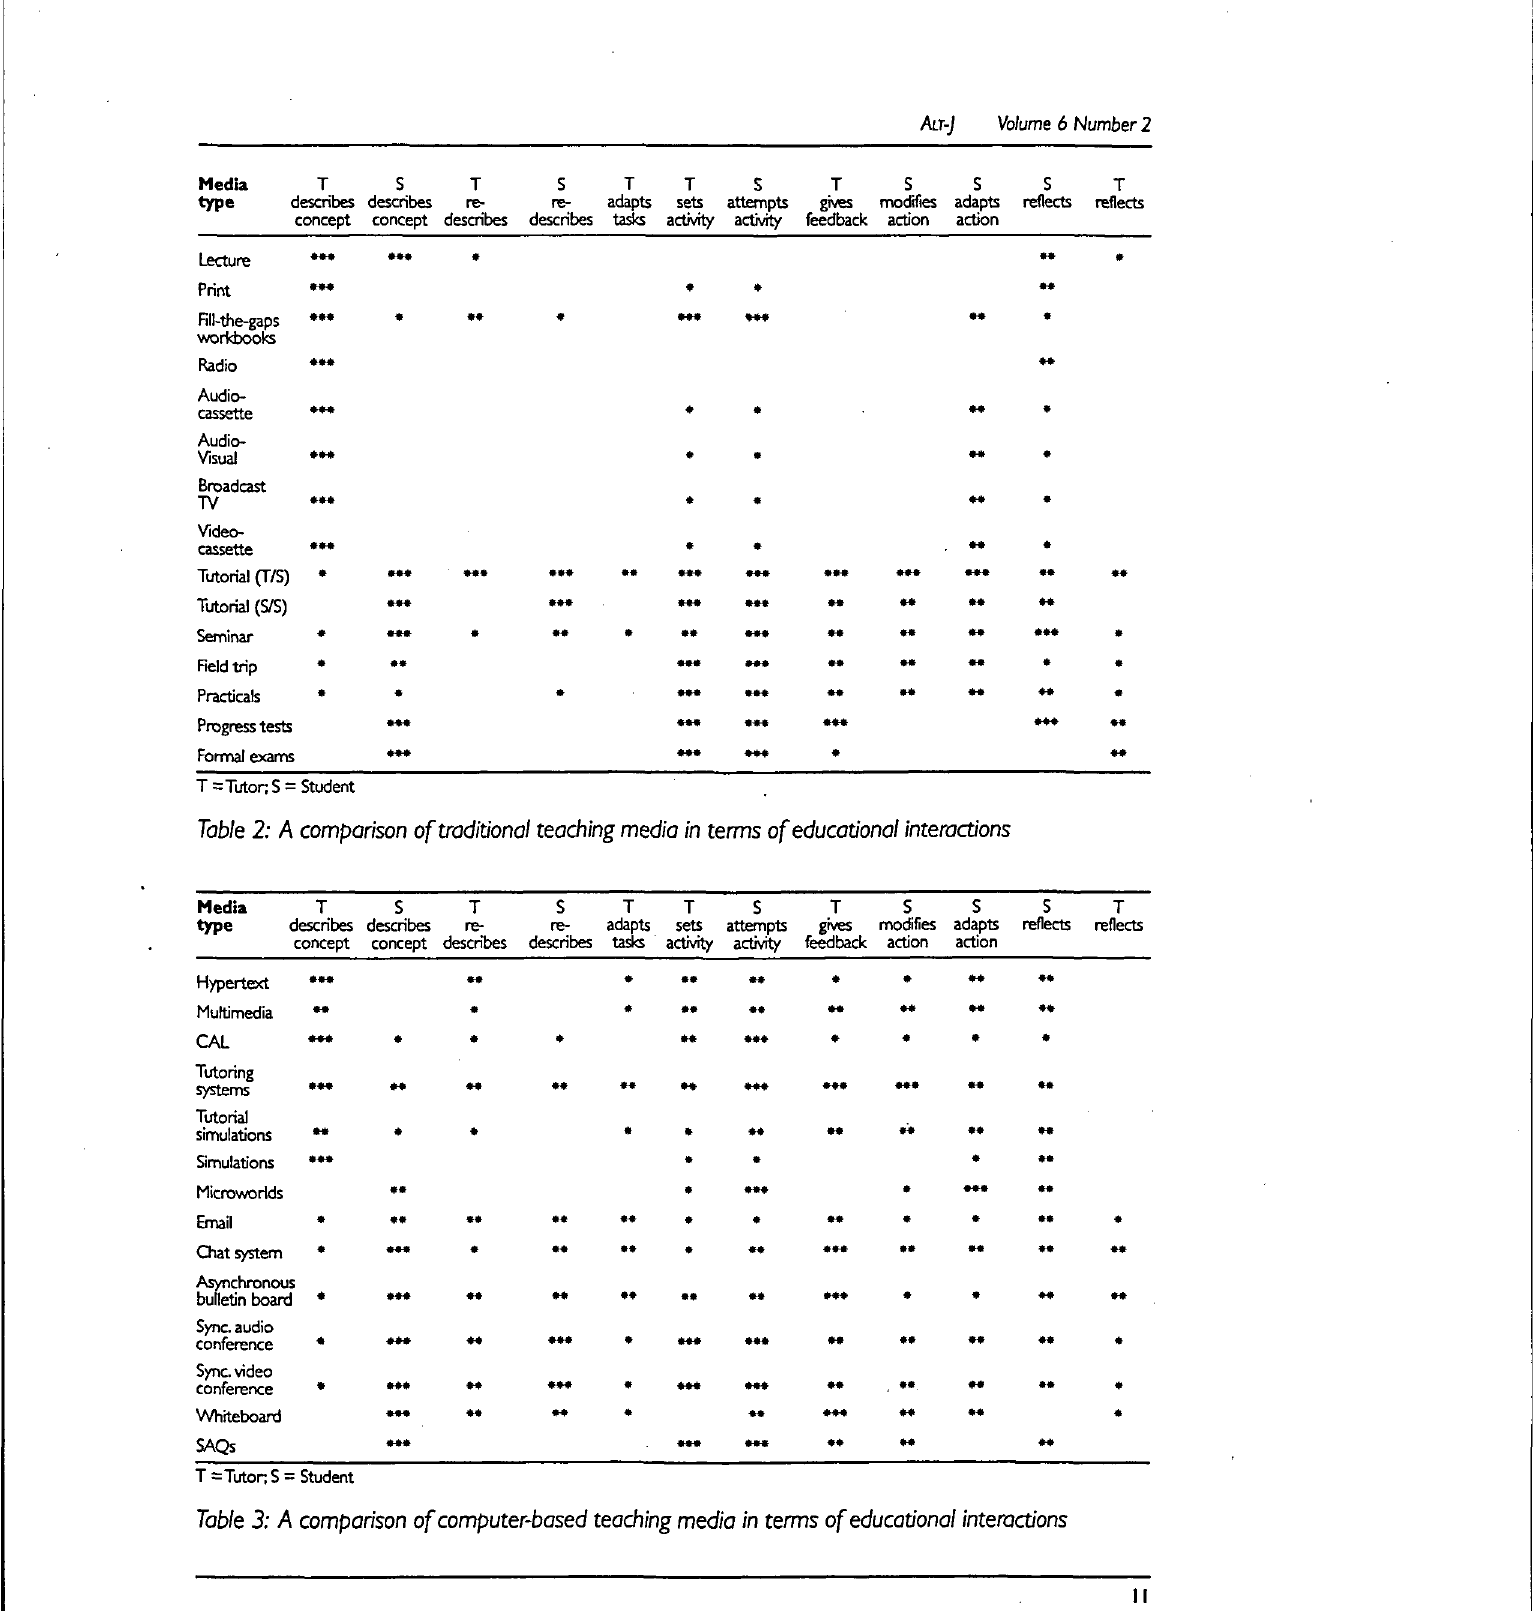
Table 3: A comparison of computer-based teaching media in terms of educational interactions